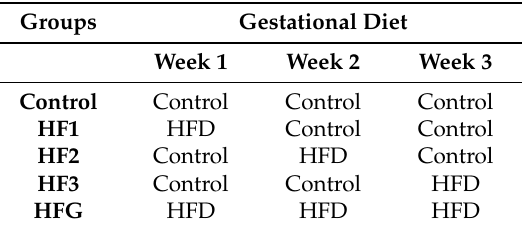
Table 1. Experimental